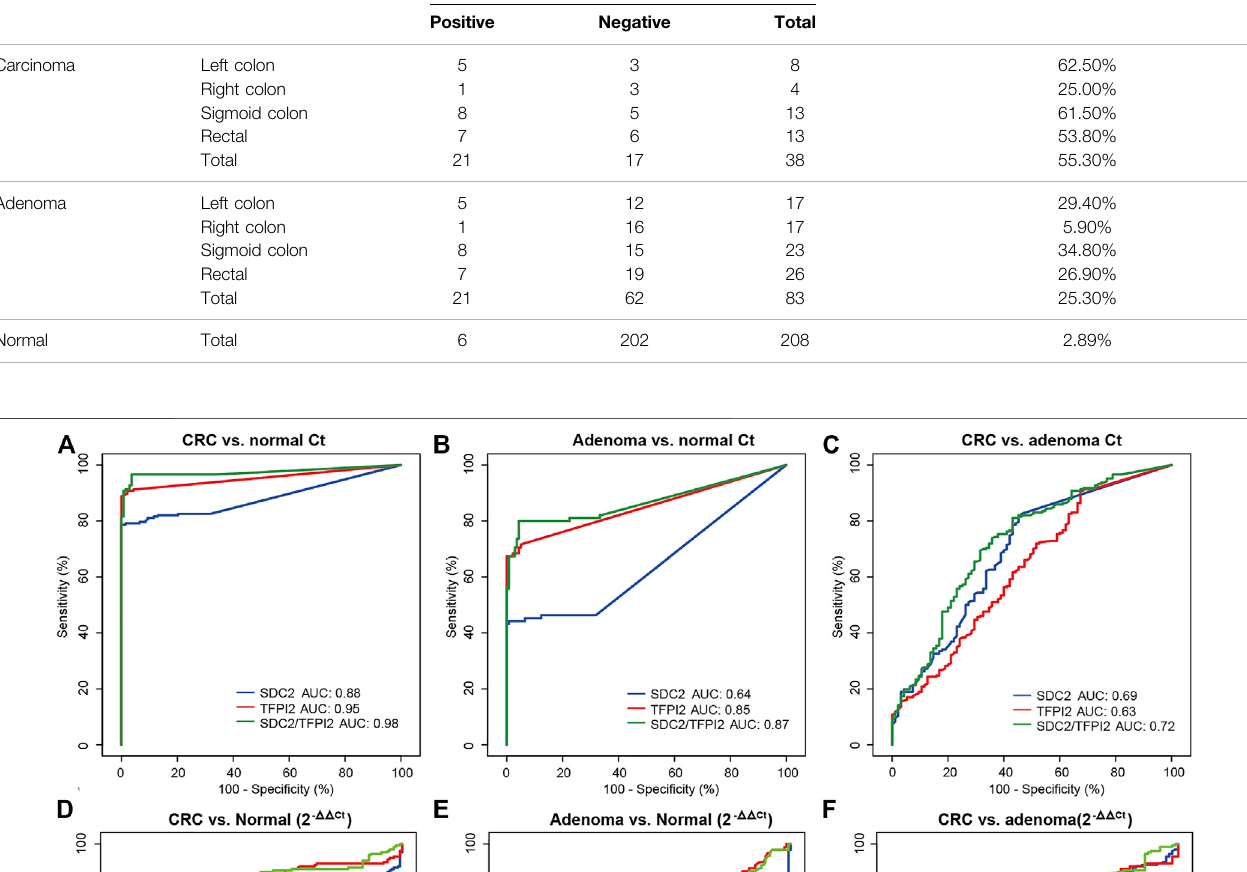
the speci fi city of 96.40% and sensitivity of 96.60%, while the AUC value of SDC2 detection was 0.88 (95% CI: 0.85 – 0.92) with the speci fi city of 100% and sensitivity of 78.60%. For adenoma vs. normal ( Figure 3B ; Table 4 ), the AUC value of SDC2 / TFPI2 - combined detection was 0.87 (95% CI: 0.81 – 0.92) with the speci fi city of 95.70% and sensitivity of 80.00%, while the AUC value of SDC2 detection was 0.64 (95% CI: 0.57 – 0.71) with the